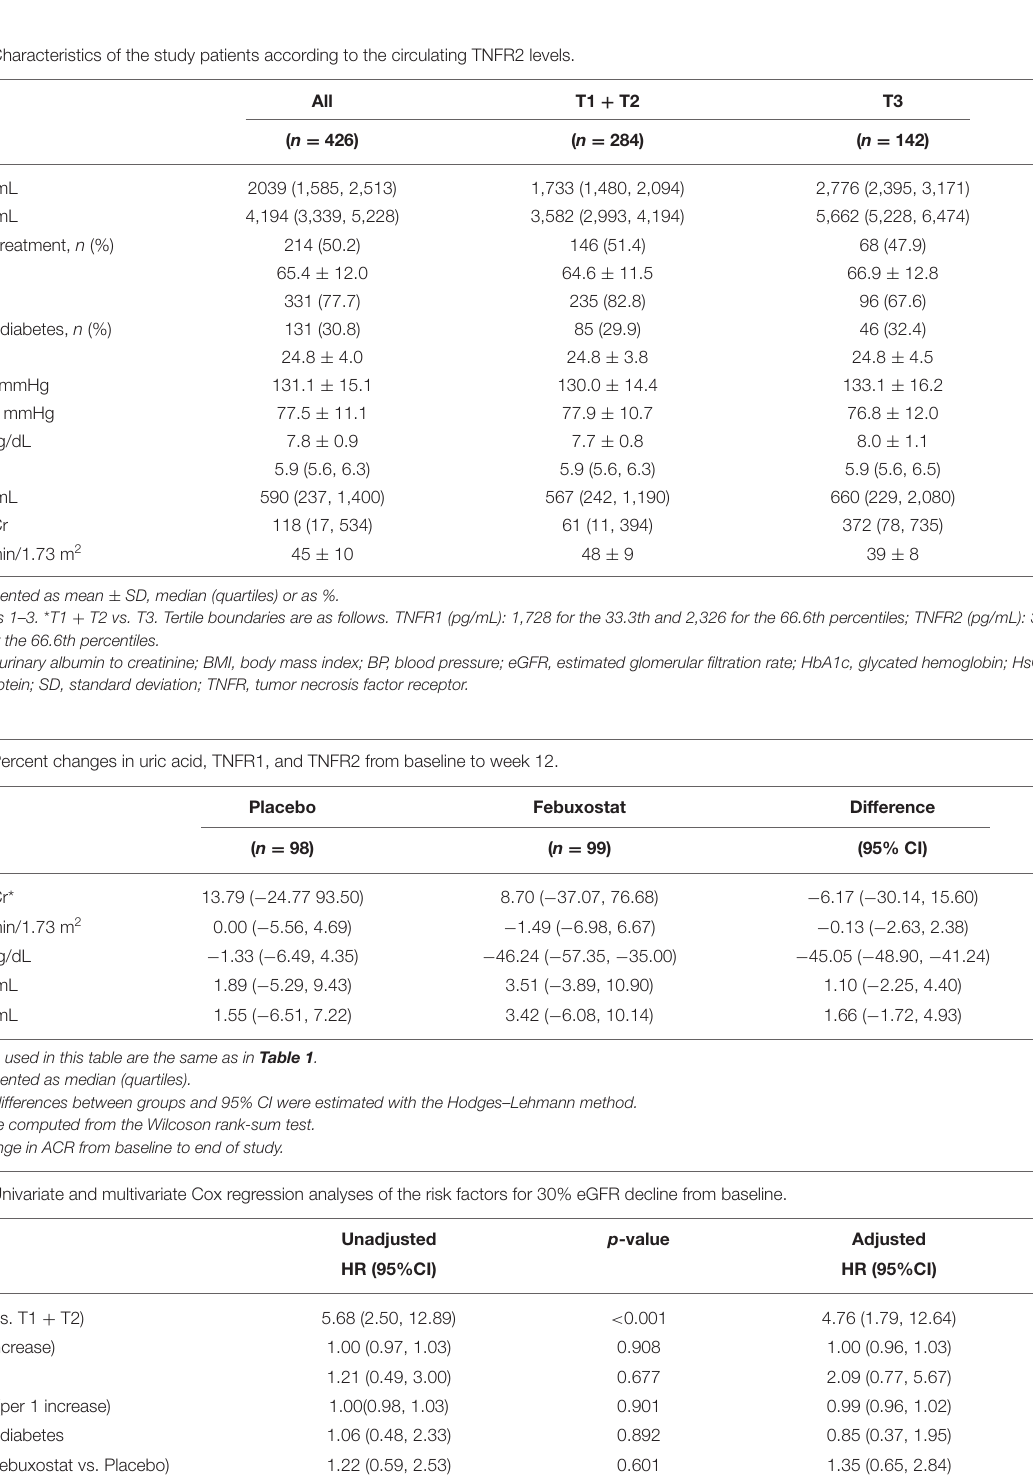
Abbreviations used in this table are the same as in Table 1 . log_, log-transformed.